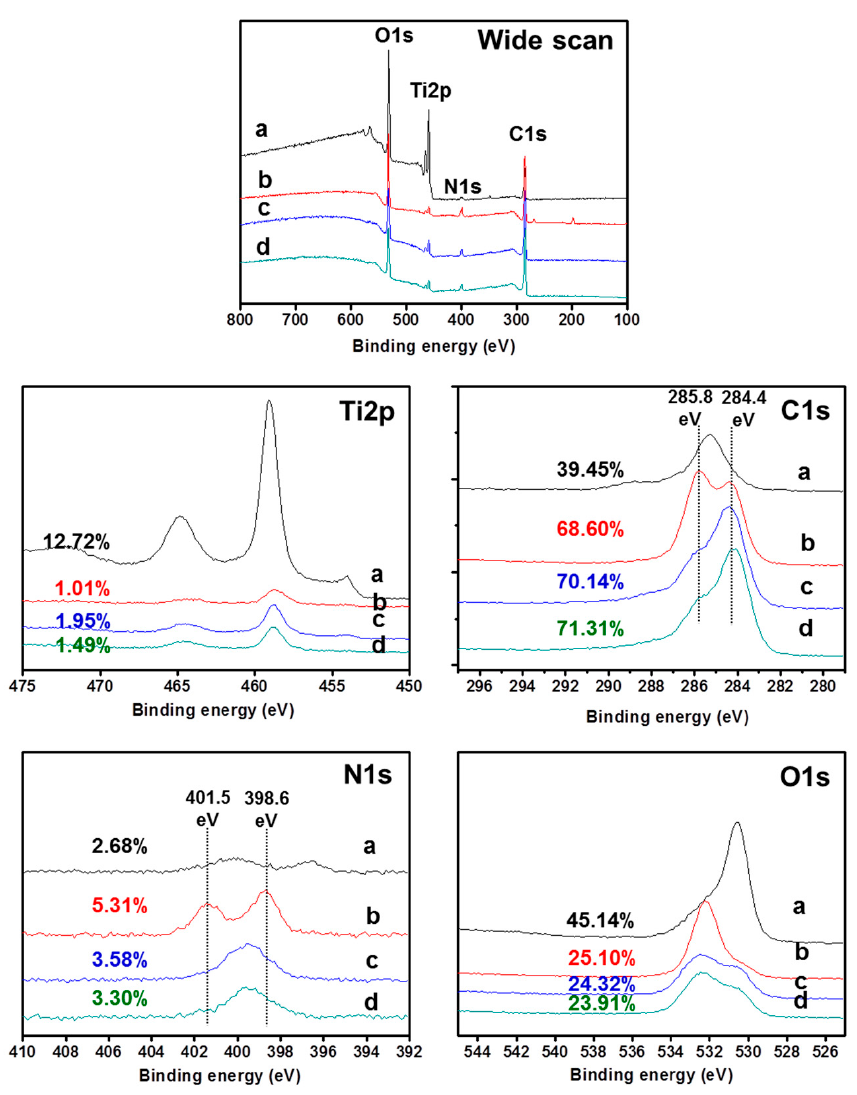
Figure 1. XPS spectra of ( a ) pristine Ti; ( b ) hBMP-2/Ti; ( c ) hGDF-5/Ti; and ( d ) hBMP-2/hGDF-5/Ti samples, as monitored from 100 to 800 eV.